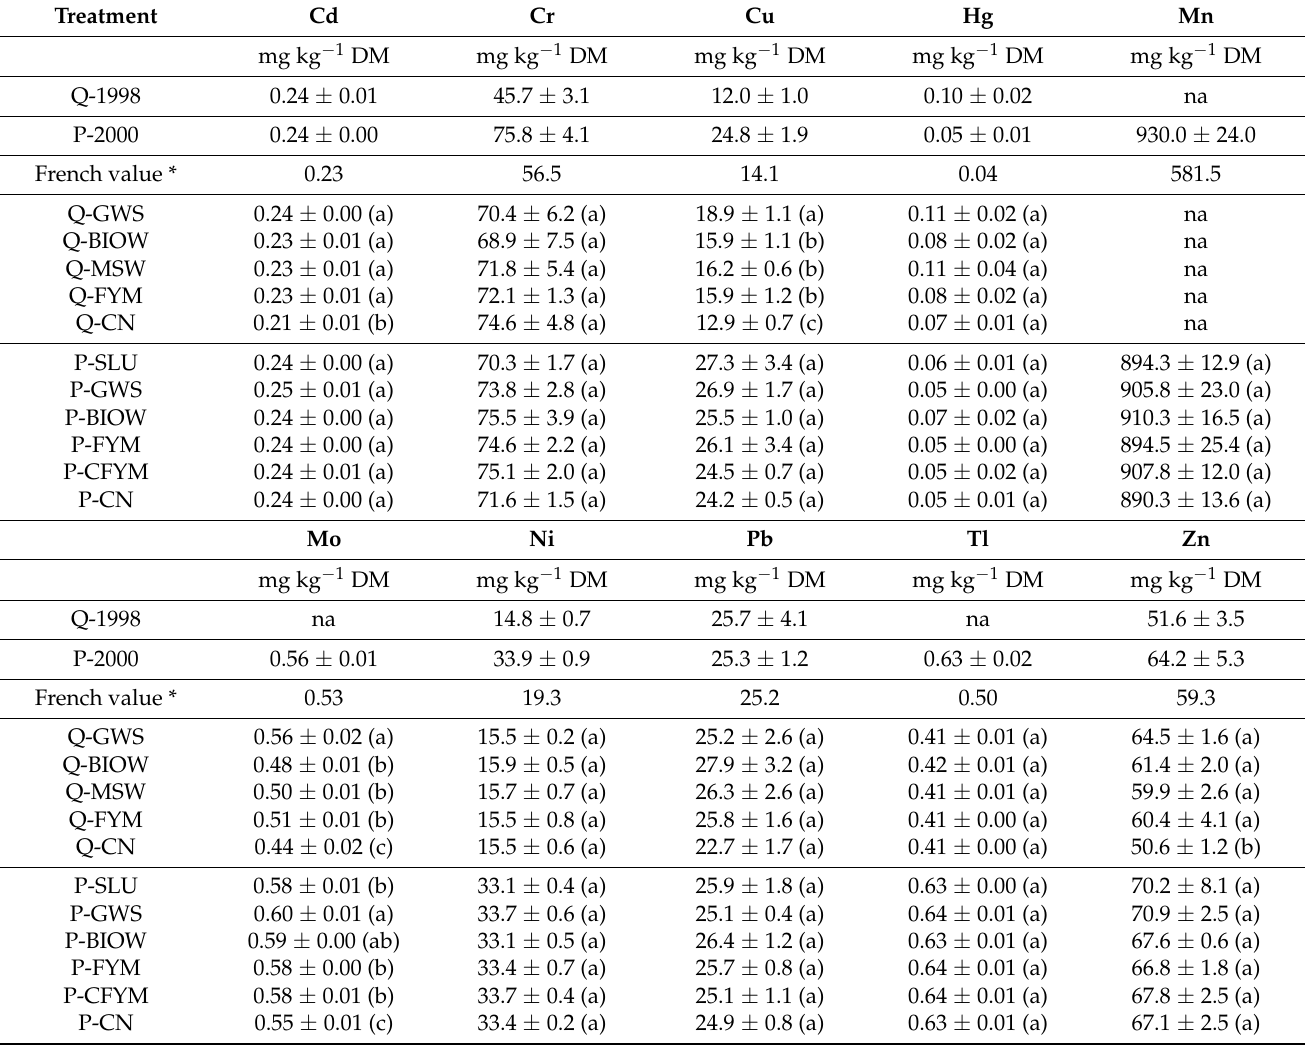
Table 5. Trace element concentrations of the topsoil layer (0–25 cm, sieved <2 mm; mg kg − 1 DM, DM for dry matter) at the initial state and after 13 and 15 years of OWP spreading, with the following data presented: initial state with mean values ± standard deviations for all plots. After 13 and 15 years of OWP spreading with mean values ± standard deviation of the four replicates (in each site, abc letters stand for significant difference between treatments with Newman–Keuls and Kruskal–Wallis tests). See Figures 1 and 2 for treatments signification. na for not